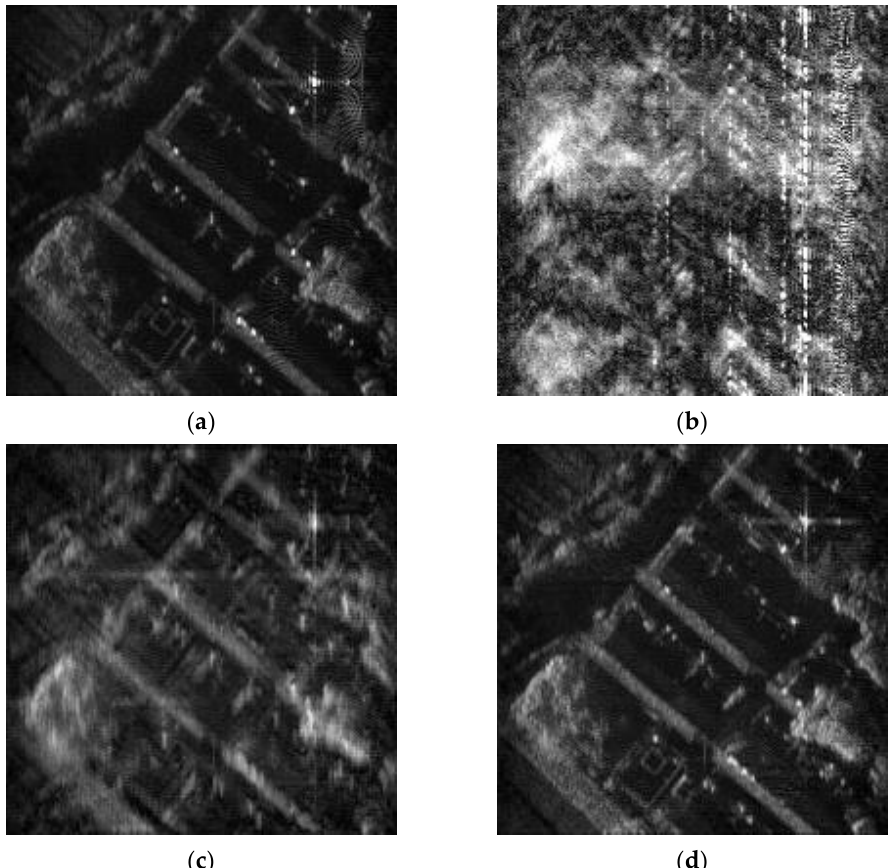
Figure 15. Imaging results of the distributed imaging scene. ( a ) Without vibration; ( b ) without compensation; ( c ) FrFT-QML-RANSAC; ( d ) Chirplet-LSSE-SRT.